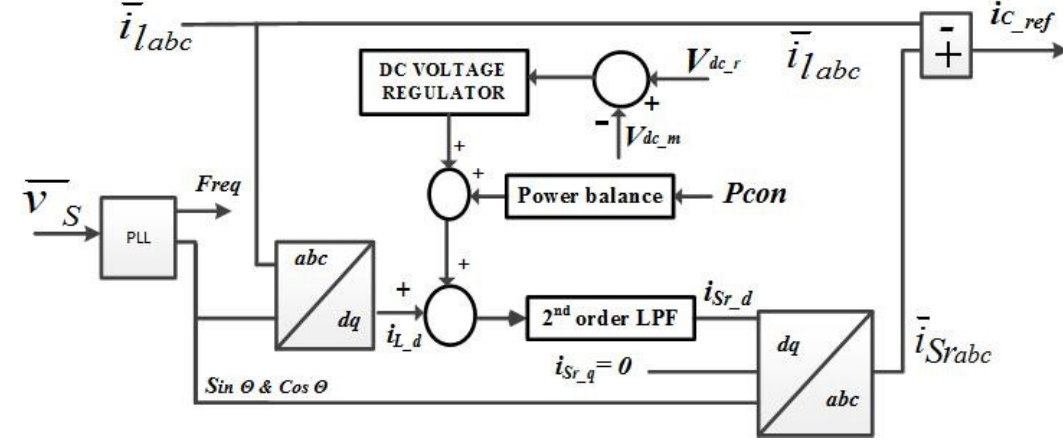
Figure 2. A block diagram for the proposed control technique.